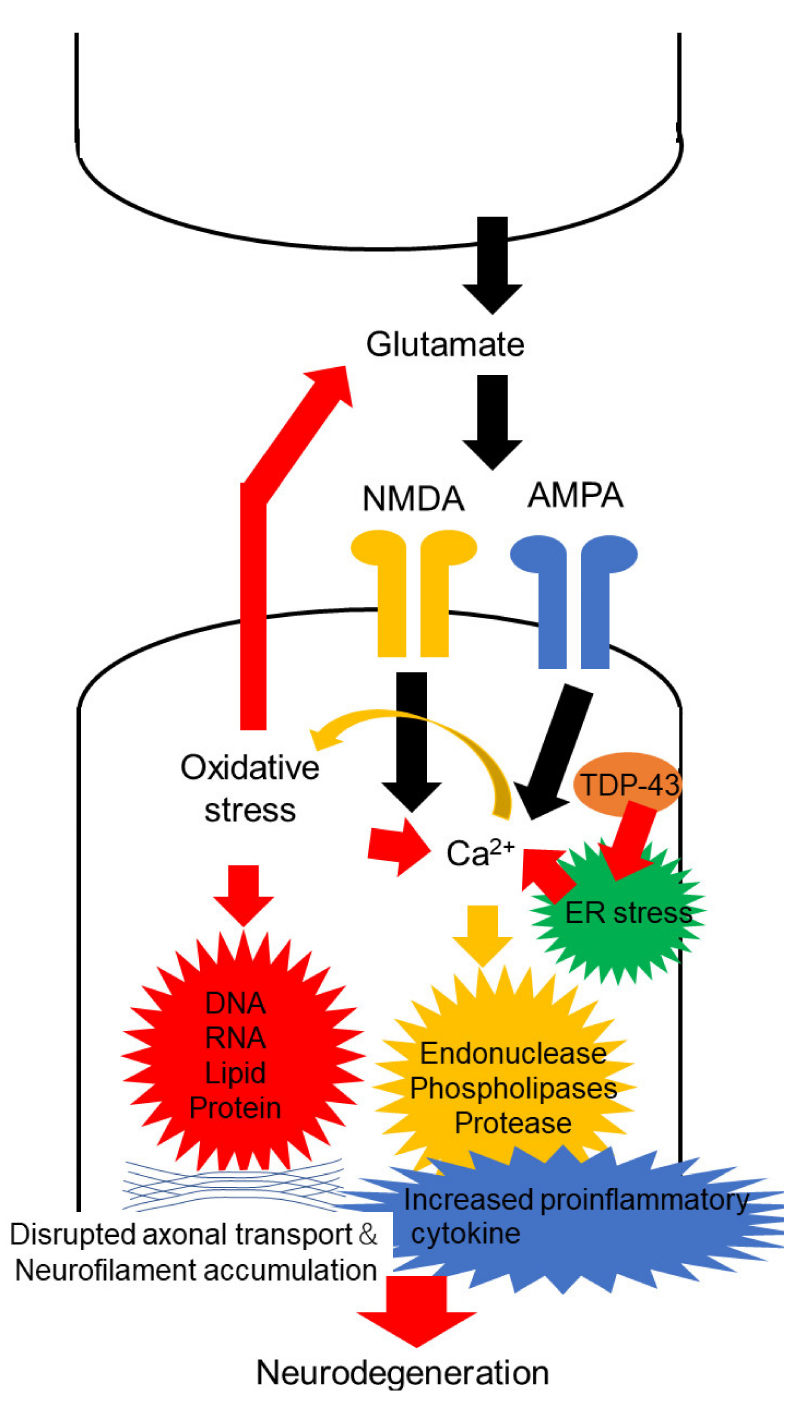
Figure 1. Neuronal excitability and free radicals accelerate motor neuron degeneration in ALS. Excessive activation of α -amino-3-hydroxy-5-methyl-4-isoxazolepropionate (AMPA) and N-methyl- D-aspartate (NMDA) receptors, mediated by glutamate, increase the influx of calcium ions (Ca 2+ ). Ca 2+ activates enzymes such as endonucleases, phospholipases and proteases, which may induce neuronal injury. Additionally, excessive activation of glutamate receptors generates free radicals and oxidative stress to thereby modulate DNA, RNA, lipids and proteins, increase glutamate concentration in the synaptic cleft and raise Ca 2+ influx into the cells. These processes accumulate neurofilaments and increase proinflammatory cytokines, which might result in neurodegeneration. Moreover, accumulation of TAR DNA-binding protein 43 (TDP-43) in the cytoplasm of motor neurons potentially induces ER stress, and ER stress leads to the release of Ca 2+ from the ER